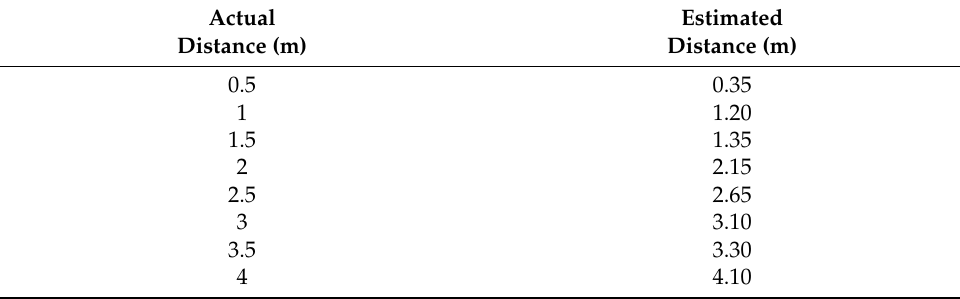
Table 1. Localization: actual and estimated distance (m).